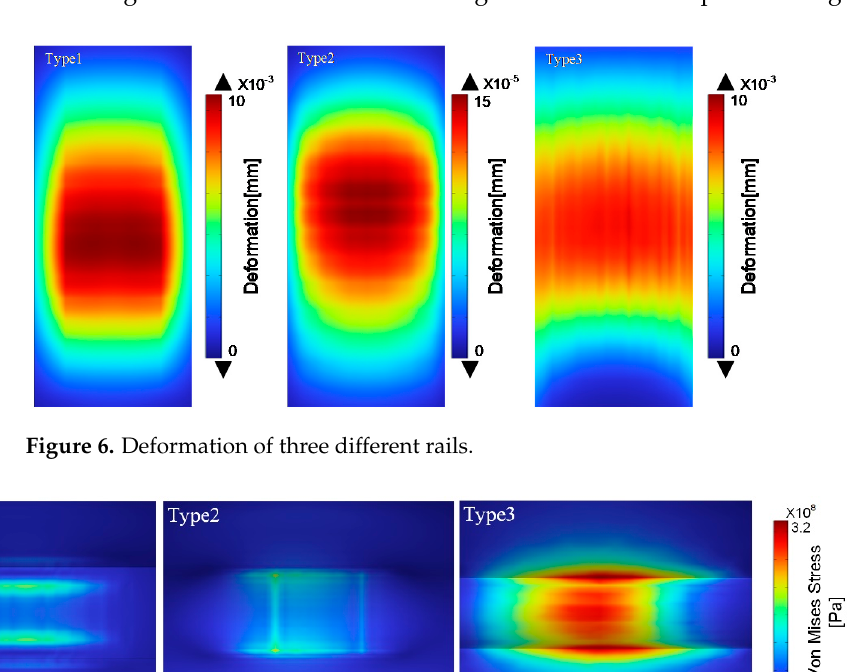
Figure 5. Inertia moment of rails with different parameters. ( a ) Varies vs. m. ( b ) Varies vs. α .